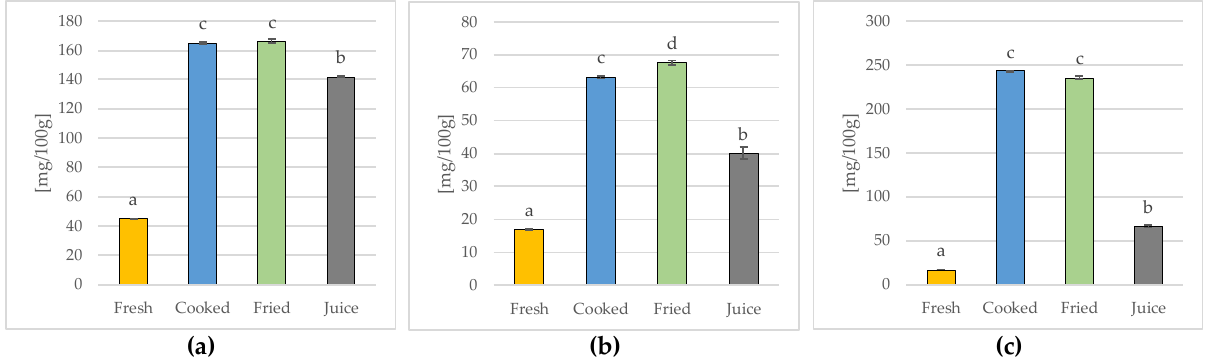
Figure 3. The sum of identified and quantified carotenoid ( a ), flavonoid ( b ), and phenolic acid ( c ) contents calculated as the sum of individual phenolic components identified by HPLC assay. Mean values ( n = 3) marked in bars by different letters differ significantly (Duncan’s test, p ≤ 0.05). The sum of determined carotenoids (Figure 3a) ranged from 44.98 ± 0.18 mg/100 g of